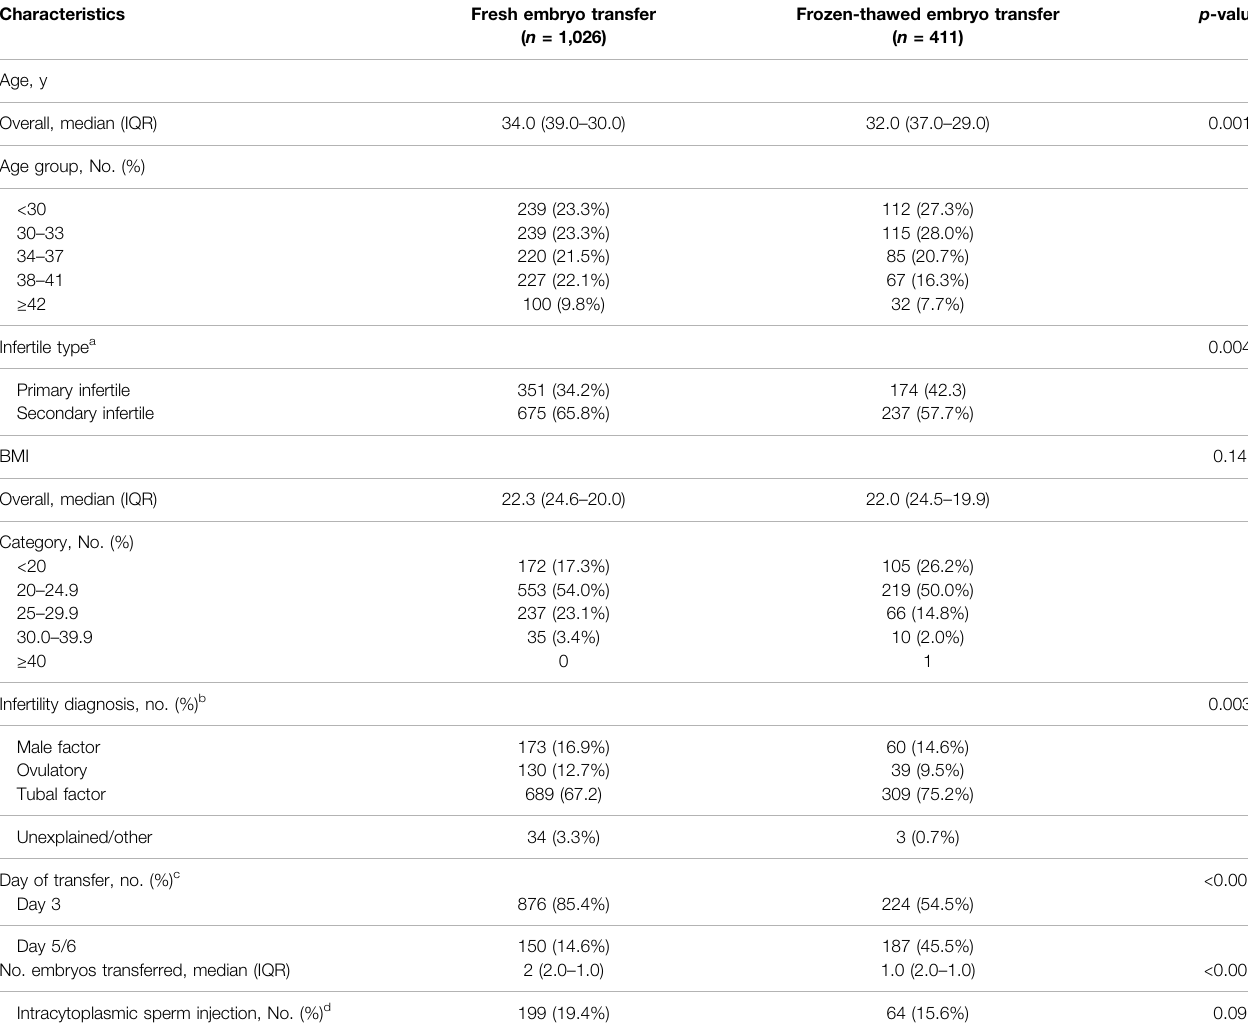
TABLE 1 | Demographics and cycle characteristics of patients. Characteristics Fresh embryo transfer